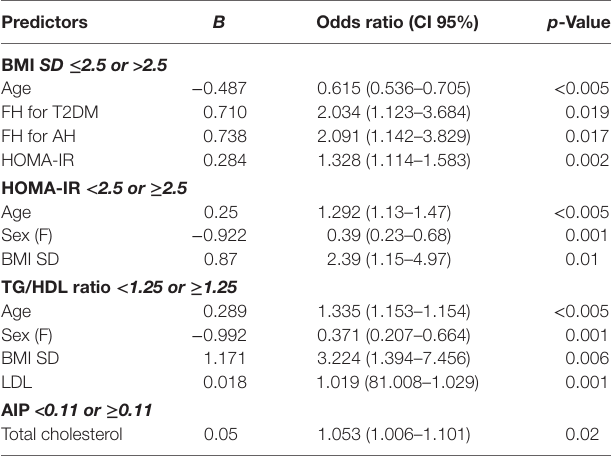
IR, TG/HDL ratio, and AIP.